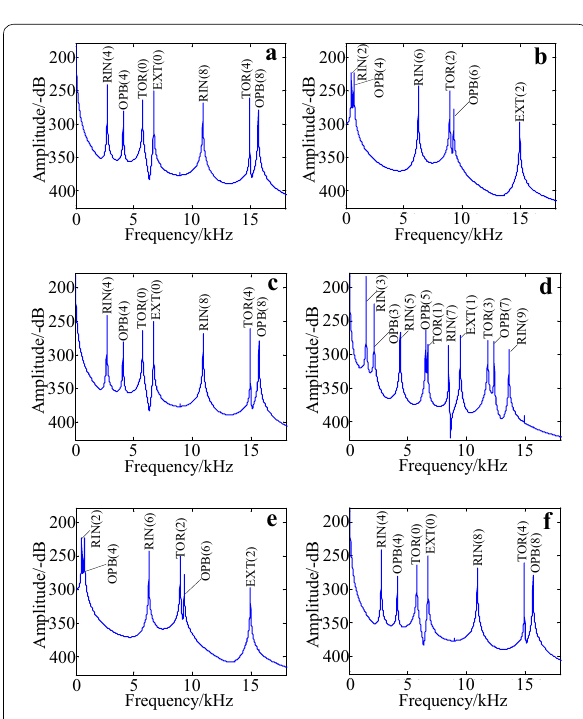
Figure 5 Harmonic responses of the helical ring gears, where a case I, b , c case II, and d – f case